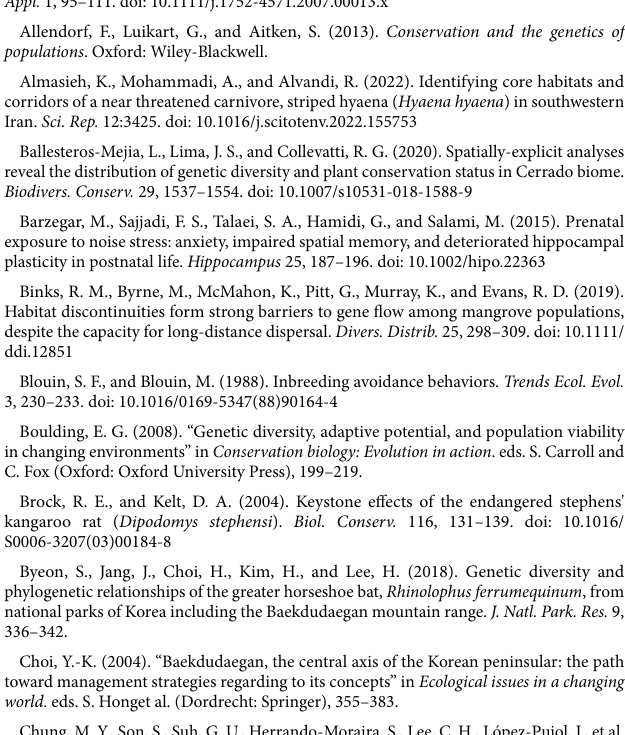
China, Kazakhstan, Europe (Germany, Italy, Hungary) and Taiwan. Numbers at the branches represent the bootstrap support values for neighbor joining (NJ)